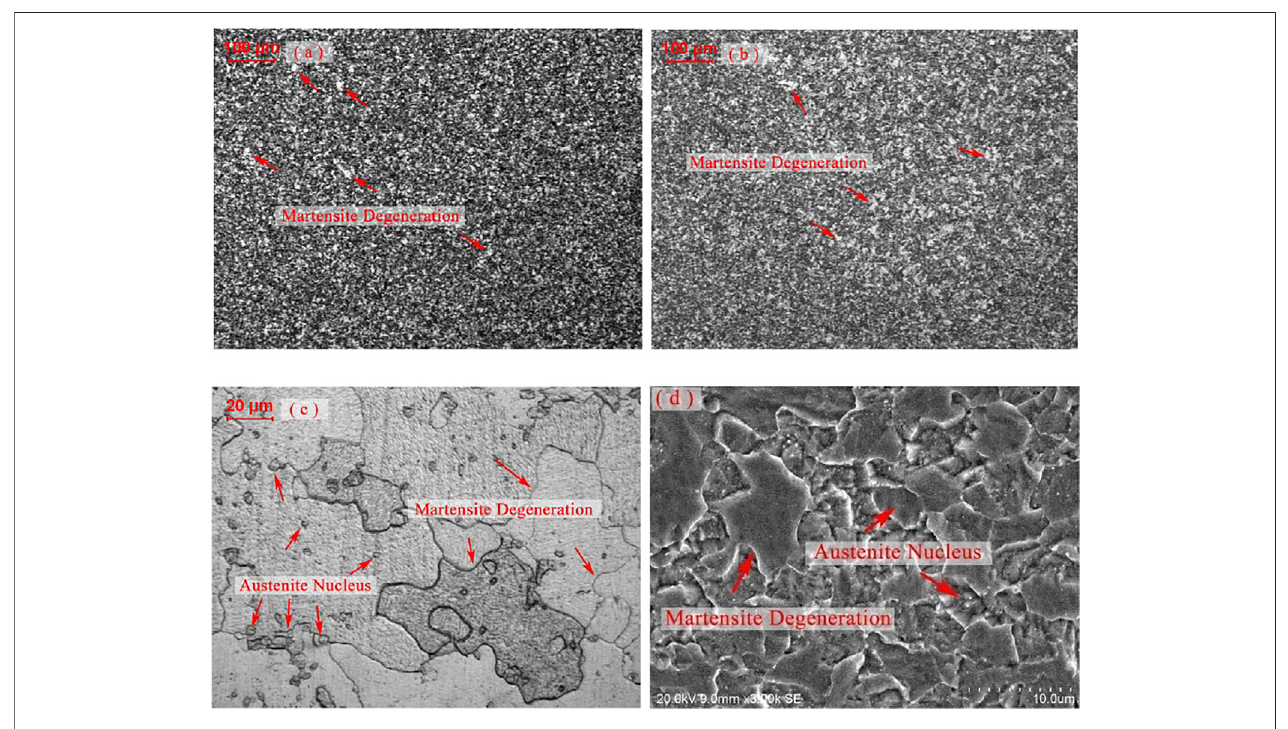
FIGURE 4 | OM/SEM images of NSM steels heated up to (A) 700 ° C, (B) 750 ° C, (C) and (D) 770 ° C.